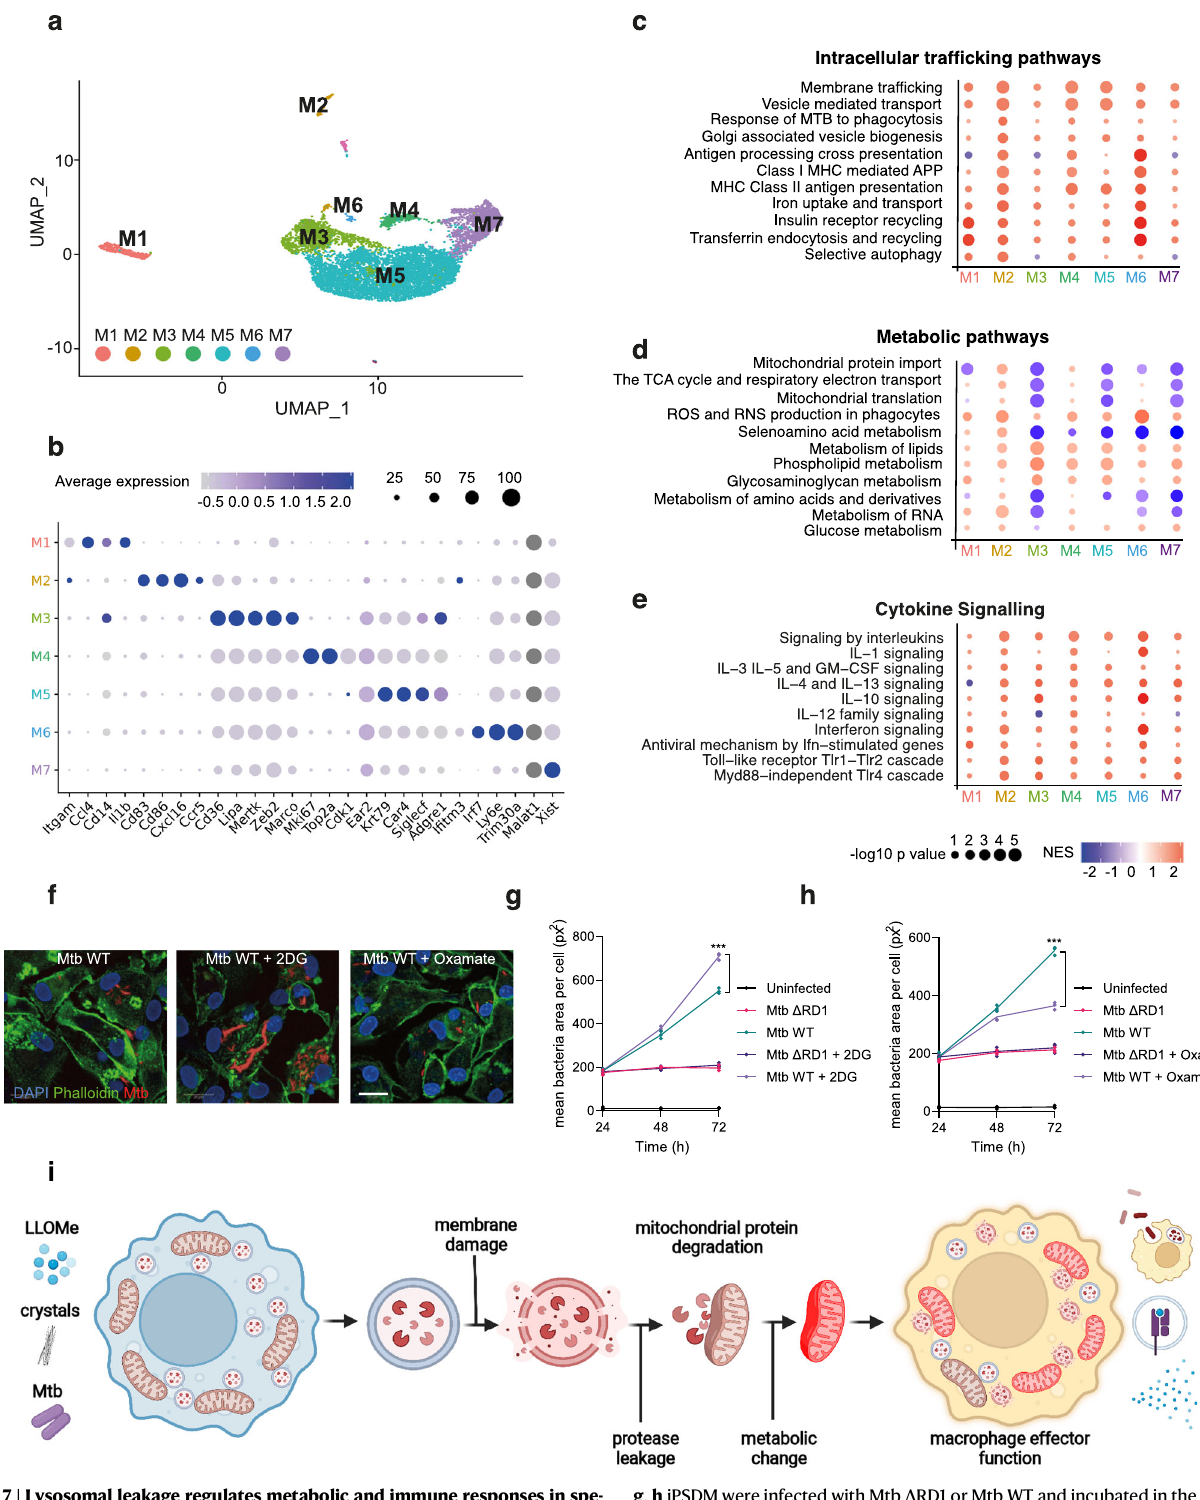
g , h iPSDMwereinfected withMtb Δ RD1orMtbWTand incubatedinthepresence or absence of 2-DG ( g ) or oxamate ( h ). Graphs show mean bacteria area per mac- rophage at 24, 48 and 72h after infection. Data represent the mean±SEM of